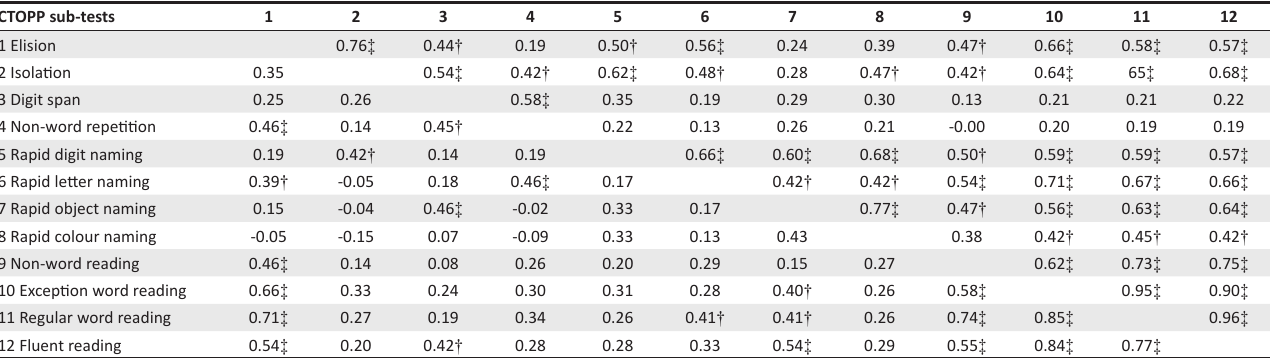
TABLE 2: Pearson’s correlations between phonological and reading measures for girls and boys. CTOPP